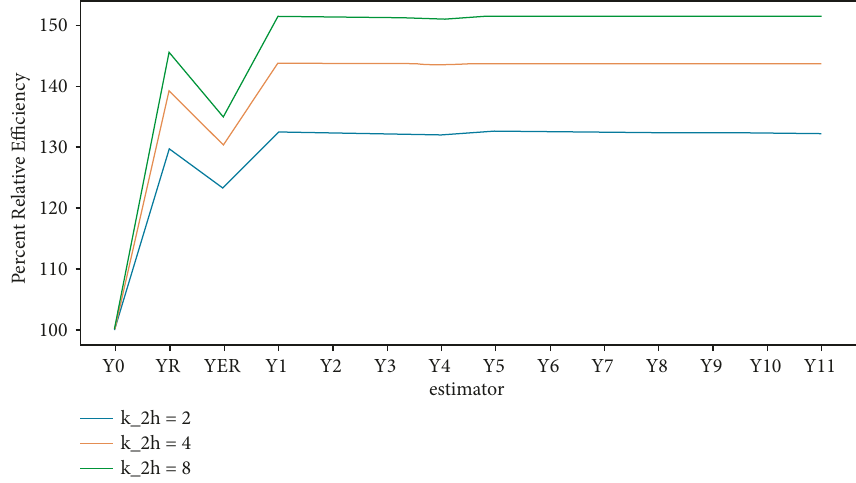
Figure 8: Plot of PREs at 30% nonresponse and 0.8 sensitivity level for population II.